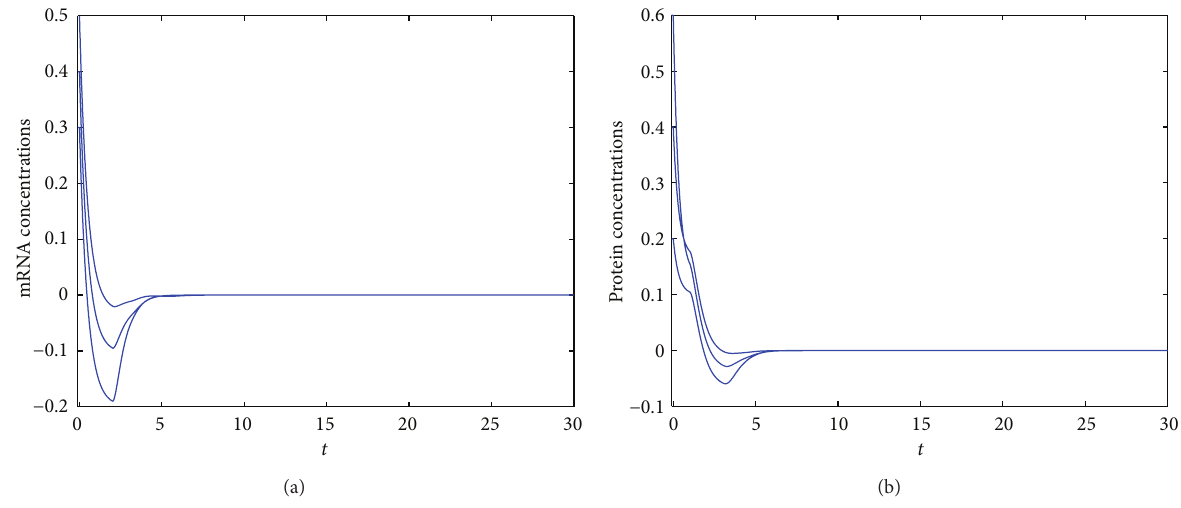
Figure 1: (a) mRNA concentrations 𝑥(𝑡) . (b) Protein concentrations 𝑦(𝑡)